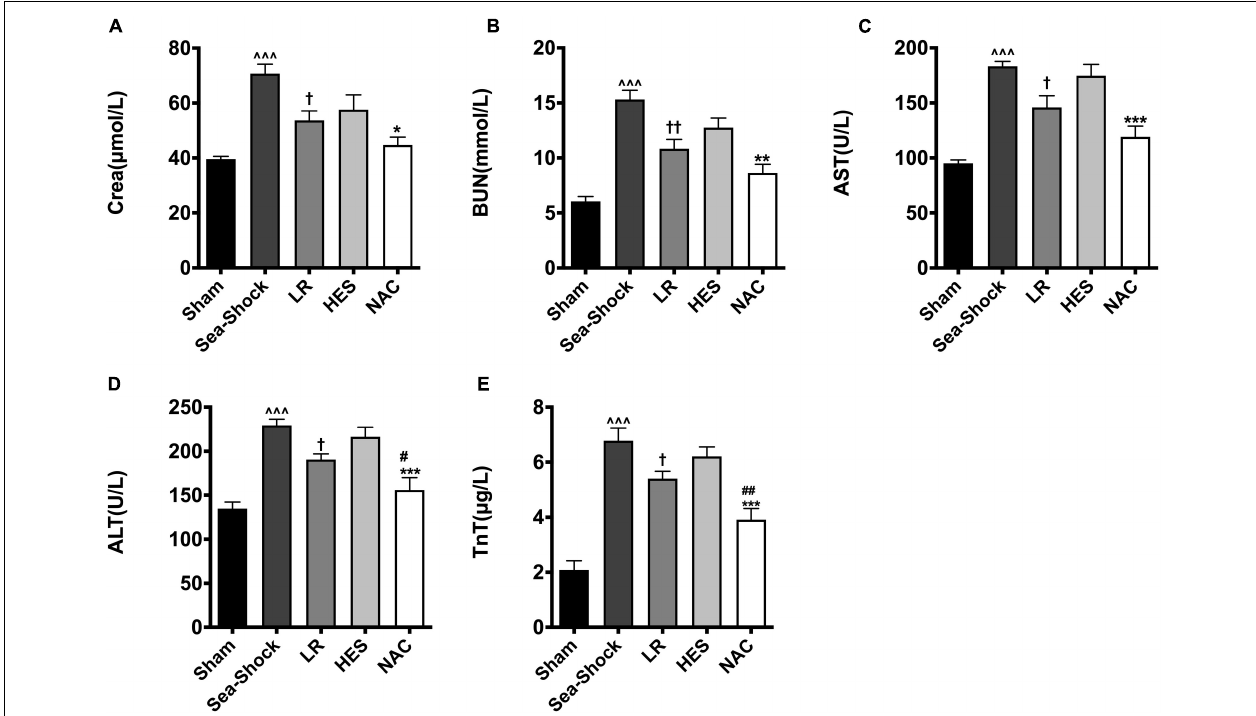
FIGURE 3 | Effects of LR solution, HES solution, and LR solution with the addition of NAC (30 mg/kg) on cardiac, liver, and kidney function. (A) Crea; (B) BUN; (C) AST; (D) ALT; (E) TnT. LR, Lactated Ringer’s; HES, Hetastarch; NAC, LR solution with the addition of NAC (30 mg/kg). Data presented as mean ± standard deviation ( n = 8/group). ˆˆˆ P < 0.001, Sea-Shock group versus baseline; † P < 0.05, †† P < 0.01, LR group or HES group versus Sea-Shock group; # P < 0.05, ## P < 0.01, LR group versus NAC group; * P < 0.05, ** P < 0.01, *** P < 0.001, HES group versus NAC